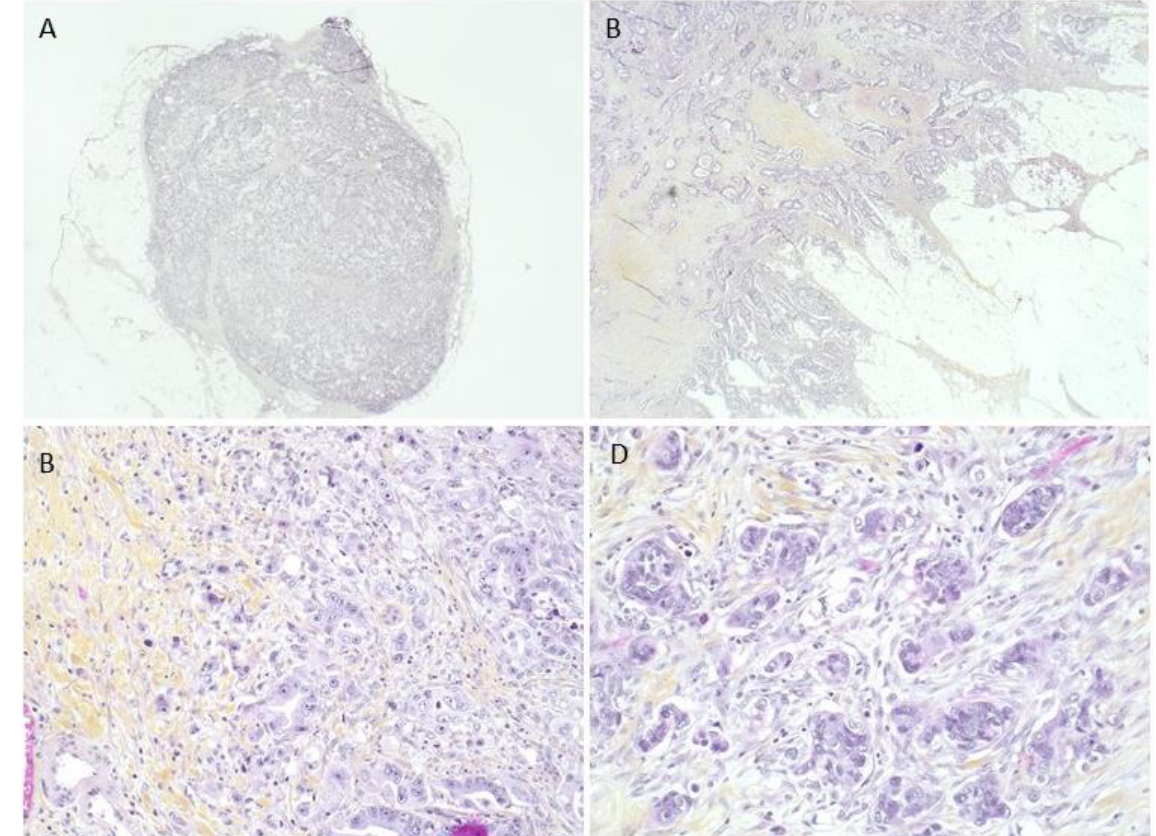
Figure 1. Prognostic histological factors studied. ( A ) Tumor deposit without identifiable lymph node parenchyma or vascular wall. ( B ) Tumor front invasion in an infiltrative mode. ( C ) High-grade budding for at least 10 isolated cells or clusters. ( D ) Poorly differentiated clusters with tumor clusters of at least 5 cells without glandular structure formation.